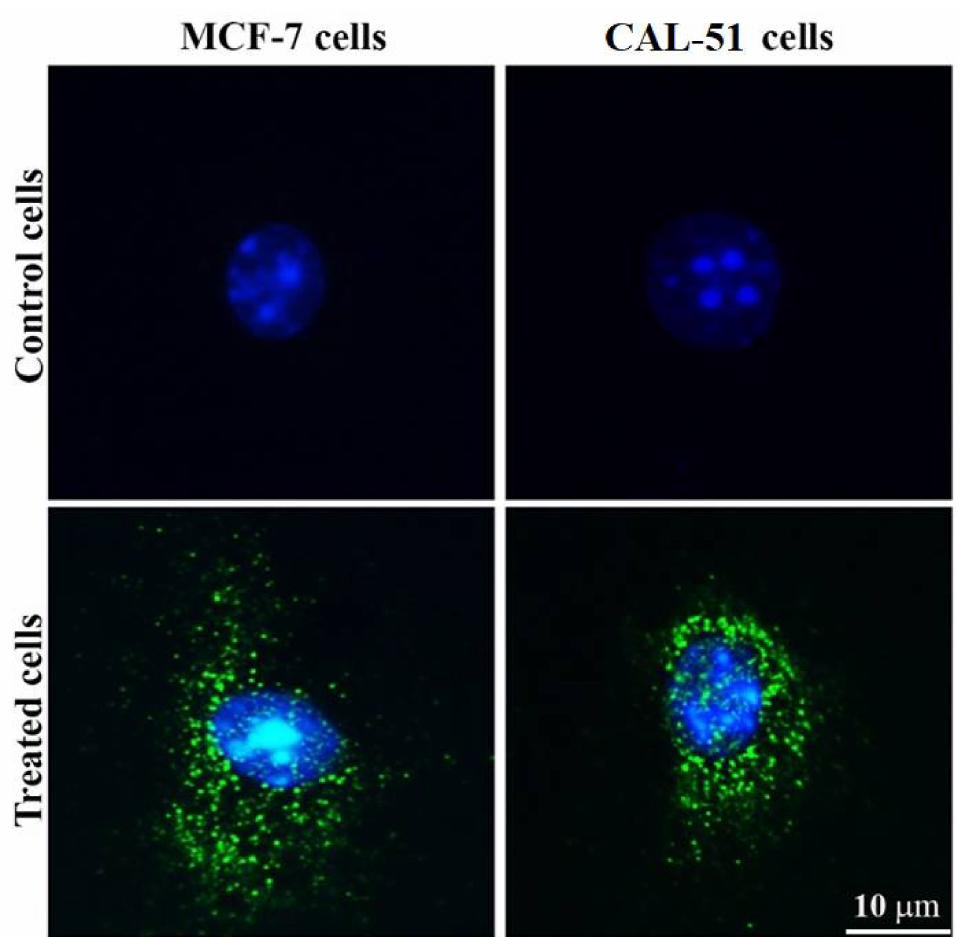
Figure 9. Uptake of fluorescent dye visualized by fluorescent microscopy. The cells were incubated with FITC-labeled TAM/RES–LbL-LCNPs for 24 h. Images were acquired at 400 × magnification.